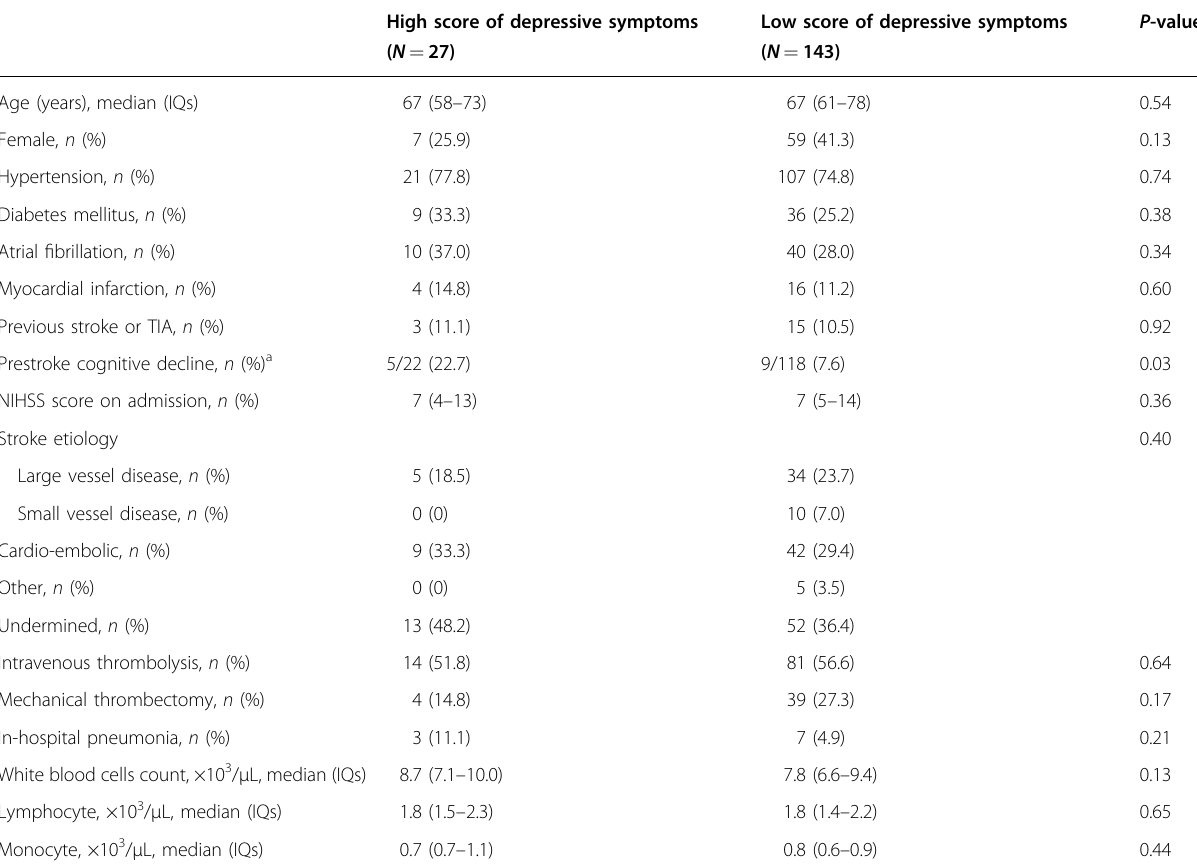
Table 1 Baseline characteristics of patients with high and patients with low depressive symptoms score on Day